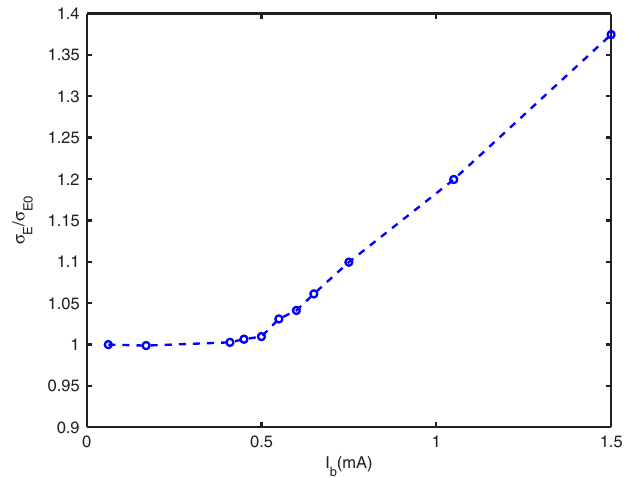
FIG. 5. (Color) Normalized energy spread as a function of the bunch current in the LER of KEKB. It shows that the threshold of microwave instability is about 0.5